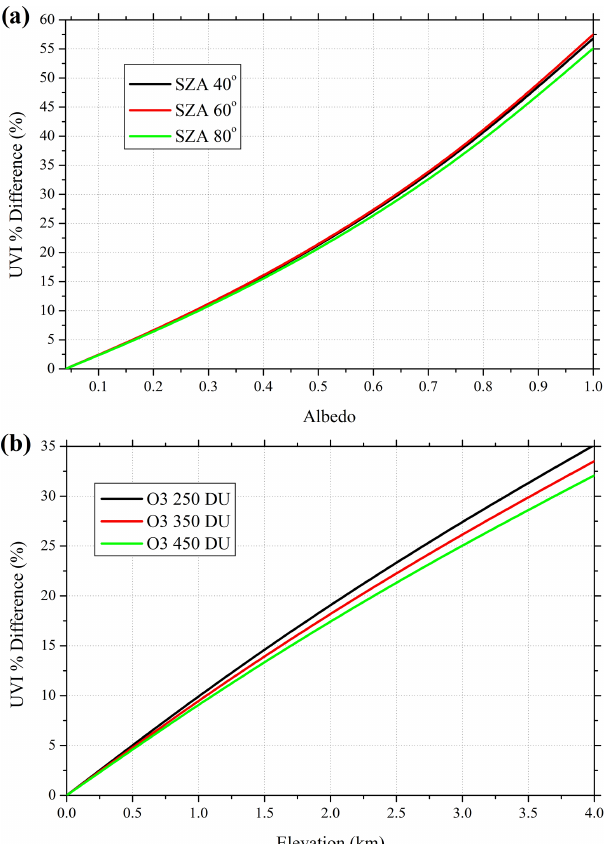
Figure 10. The surface albedo effect on UVI as a function of per- centage difference for various SZAs (a) . The surface elevation ef- fect on UVI as a function of percentage difference for various total ozone columns (b)